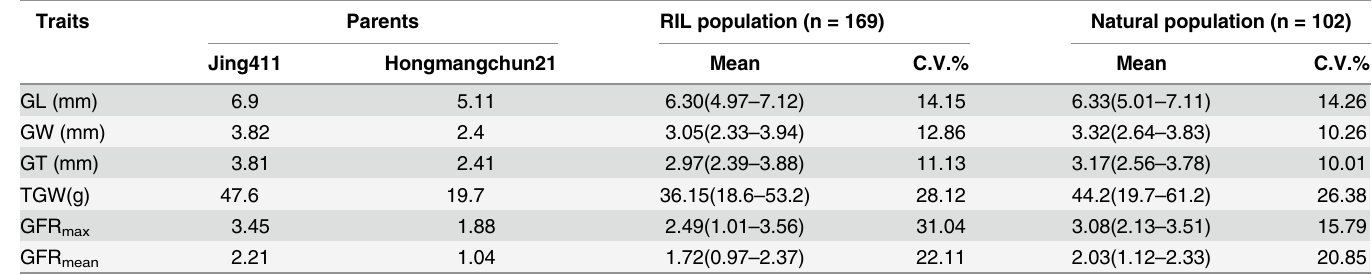
The means performance of grain traits were measured in fi ve cropping seasons (RIL population), and two cropping seasons (natural population), respectively. The data in parentheses mean the range of grain traits values. GL, grain length; GW, grain width; GT, grain thickness; TGW, 1000-grain- weight; GFR max and GFR mean , maximum and mean grain fi lling rate, respectively; RIL, recombinant inbred